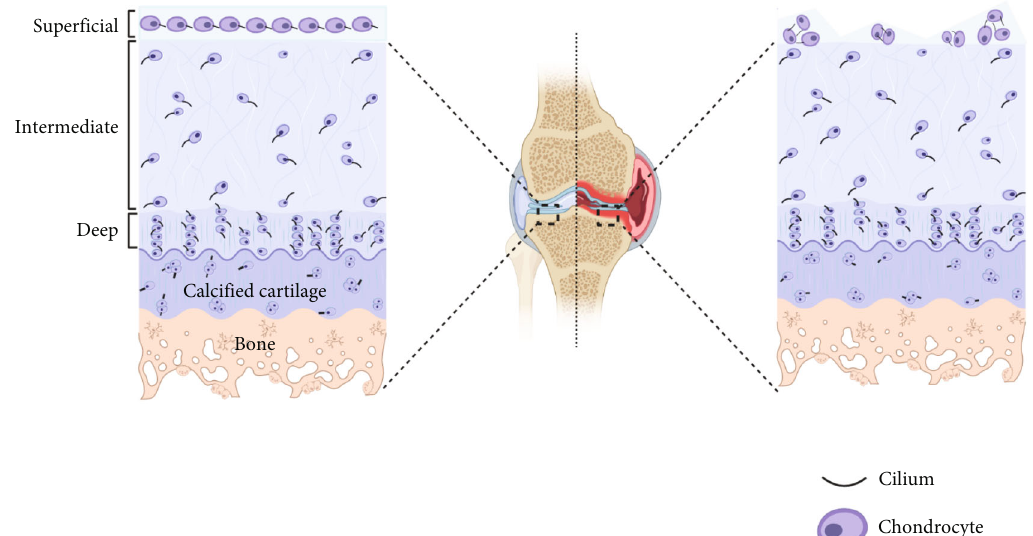
Figure 2: Cilium in normal and osteoarthritis (OA) articular cartilage tissues. The normal articular cartilage can be divided into super fi cial, intermediate, and deep zones as shown in fi gures. In the super fi cial zone of normal articular cartilage (left), the chondrocytes are ellipsoid. Both chondrocyte and cilia are parallel to the surface of articular cartilage. In intermediate and deep zones, the chondrocytes are irregular, but the cilium orientation is on the medial or lateral cell membranes along the longitudinal axis parallel to the chondrocyte. However, the articular surface is eroding in human OA tissue, and the cilium incidence and length signi fi cantly increased compared with normal human articular cartilage [40]. Moreover, the cilia are oriented parallel to the long axis of cells at the articulating surface in normal articular cartilage, but it is oriented to the center of abnormal cell clusters in osteoarthritic